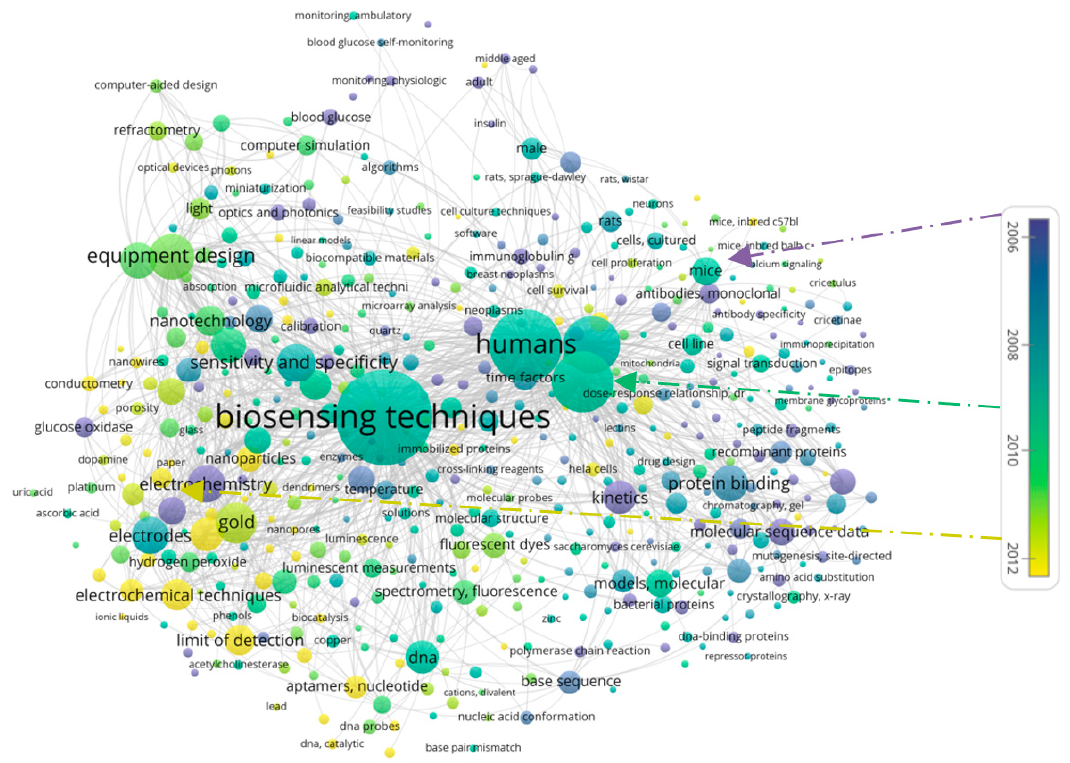
Figure 21. Co-occurrence analysis of MeSH Terms with a time overlay. Table 6. Older MeSH Terms among those depicted in Figure